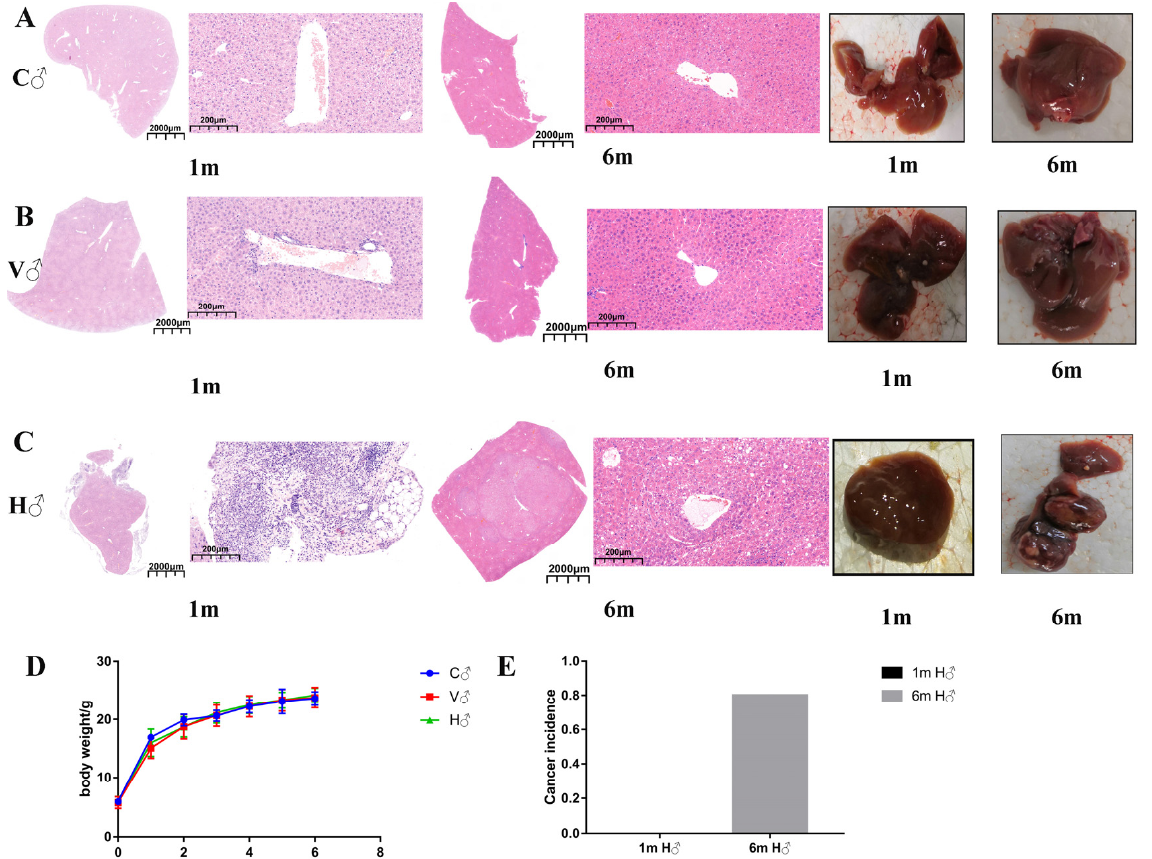
Figure 1. DEN/CCl 4 -induced HCC model was successfully established in male mice, and tumor formation was obvious after 6 months of administration. ( A ) Both representative total appearance and HE staining in group C showed no lesions at 1 month or at 6 months. ( B ) Both representative total appearance and HE staining in group V showed no lesions at 1 month or at 6 months after administration. ( C ) Both representative total appearance and HE staining in group H showed developed vacuolar degeneration, but no tumor formation at 1 month after administration, and both representative total appearance and HE staining showed obvious tumor formation at 6 months after administration. Hematoxylin and eosin; full scan image (×1.0), bars = 2000 μ m; single-field image (×200), bars = 200 μ m. ( D ) No differences were observed between the different groups in terms of body weight after CCl 4 administration. ( E ) Cancer incidence was 0% within 1 month after administration and 80% within 6 months after administration. (C—control WT group; V—solvent WT group; H—HCC WT group; 1m/6m—1 month/6 months after administration; ♂ —male mice).